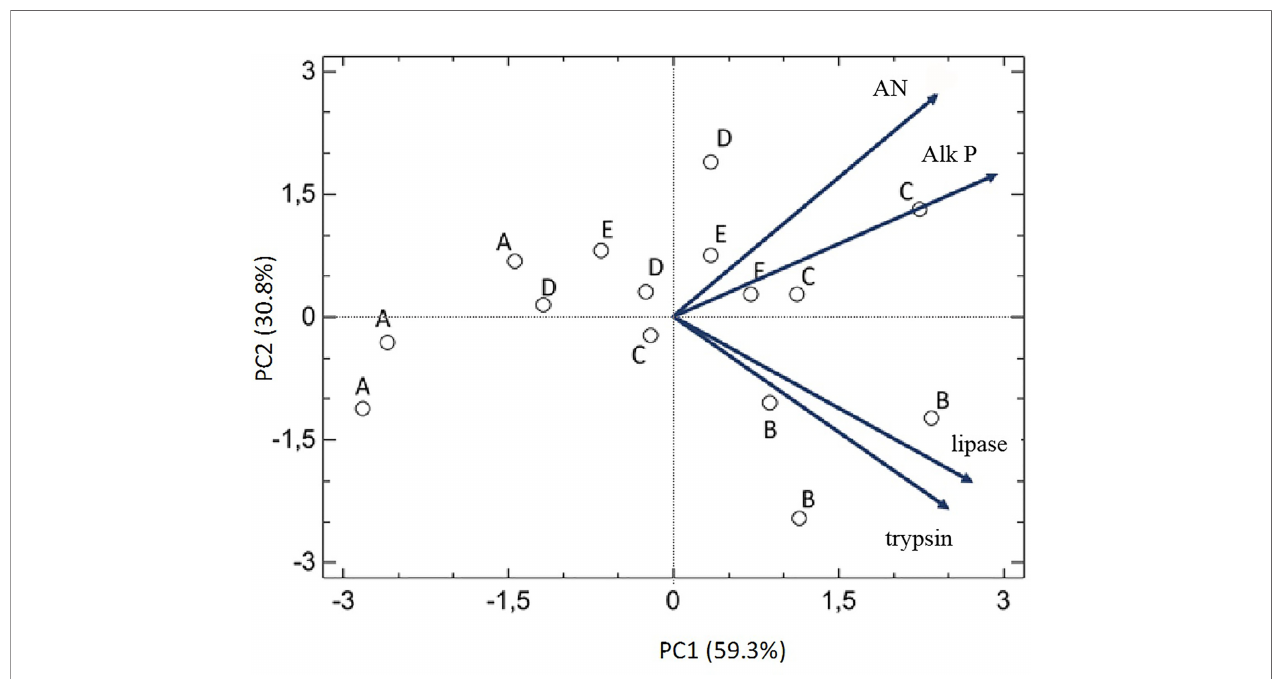
FIGURE 5 | Principal component analysis (PCA) correlation biplot based on the fi rst two principal components (PC1 and PC2) generated from the activity of different digestive enzymes in the different experimental